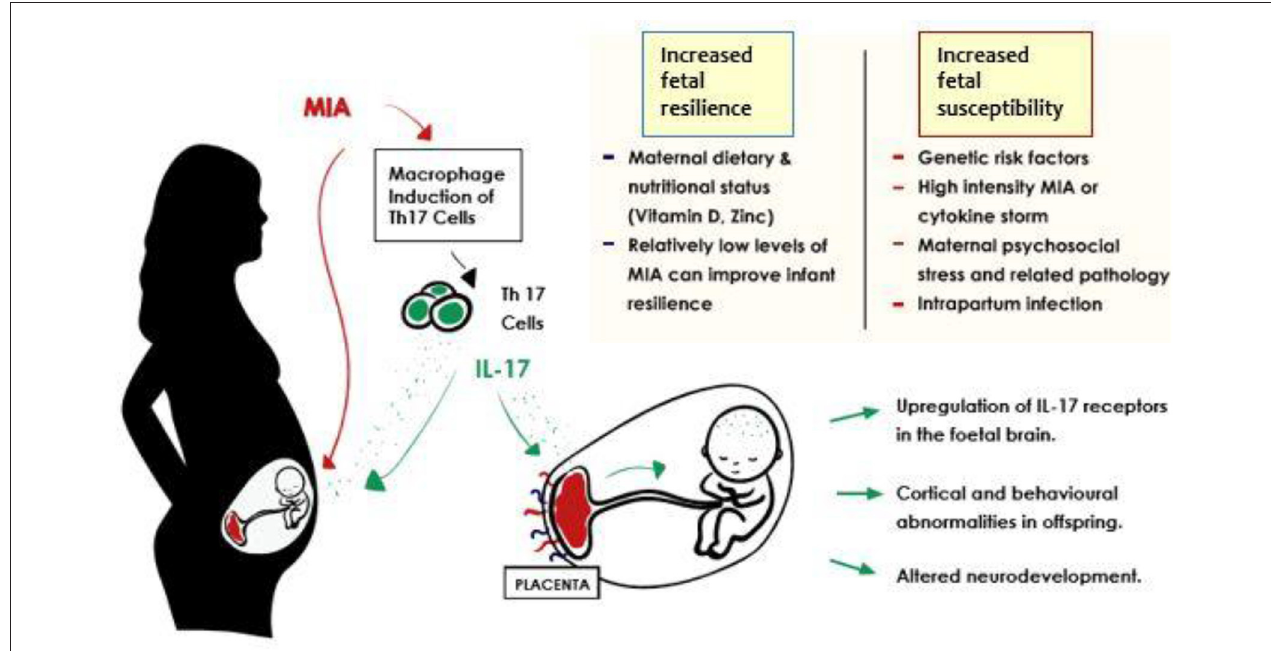
FIGURE 1 | Potential outcomes in the inflammation-exposed fetus in the context of MIA related IL-17 induction. Improved fetal resilience is associated with lower intensity of maternal immune activation. Autism spectrum disorder risk after prenatal exposure to maternal fever has been found to increase in a dose dependent manner ( 55, 56) and similar effects were identified in animal models of MIA (57). A balanced maternal diet seems to contribute to improved fetal resilience also (58–60). Exposure to relatively higher grades of immune activation via high intensity MIA ( 40), intrapartum infection (61, 62), and genetic risk factors lead to reduced fetal resilience, and increased likelihood of unfavorable developmental